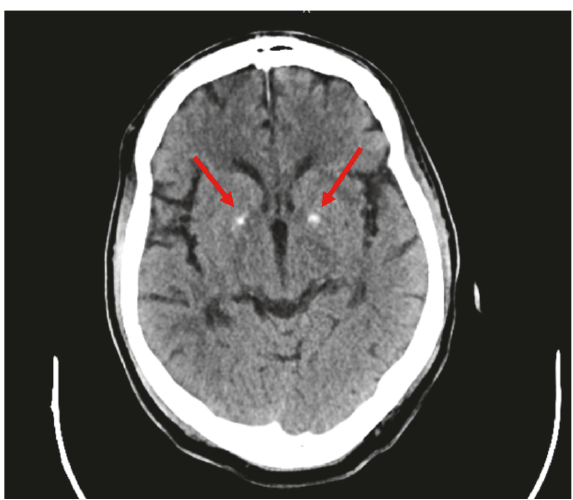
Figure 1: CT scan without contrast showing bilateral basal ganglia